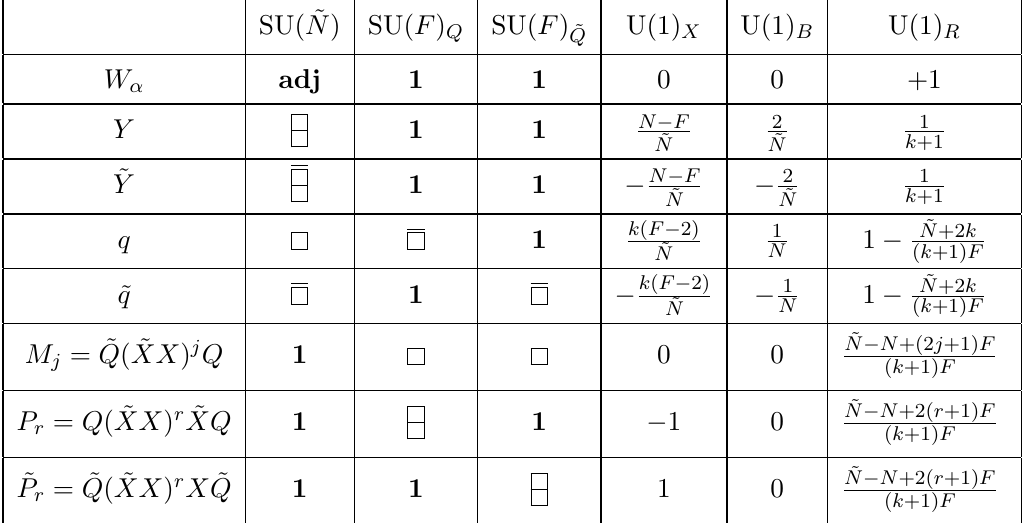
˜ ˜ N ) ( N = (2 k + 1) F − 4 k − N ) SQCD